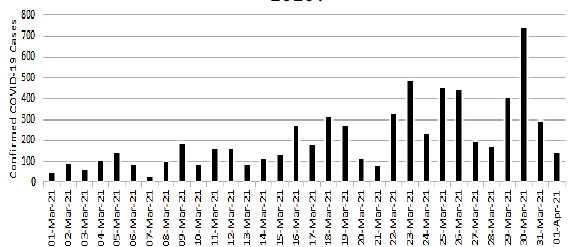
Figure 8. Daily Cases on Taguig City from March 01-31, 2021.